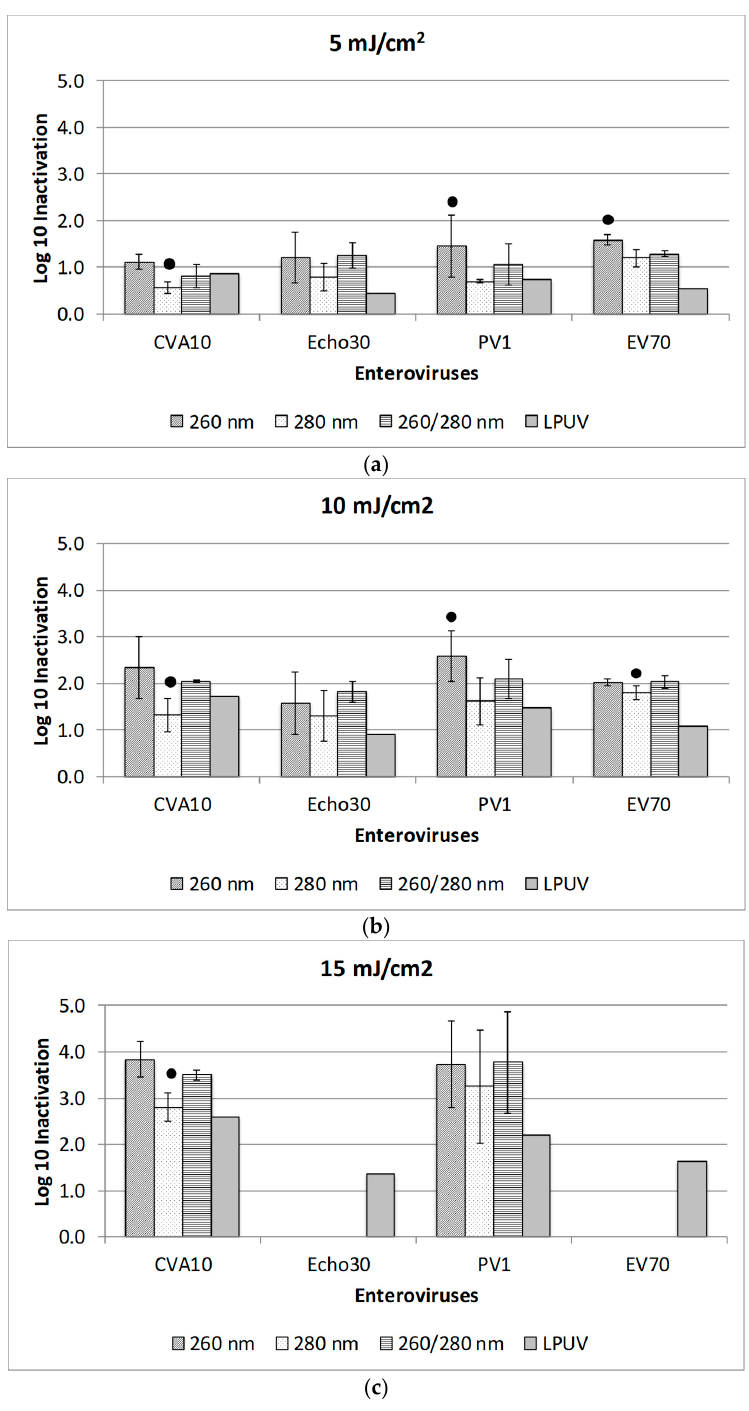
Figure A1. Comparison results of log 10 inactivation rate from the 5 mJ/cm 2 ( a ), 10 mJ/cm 2 ( b ), and 15 mJ/cm 2 ( c ) irradiation of UV-C LEDs for four human enteroviruses. The error bars represent 1 standard deviation. Symbol ( ● ) represents the p value of <0.05 among three wavelengths, as determined by ANOVA. Echo30 and EV70 for a UV dose of 15 mJ/cm 2 were not determined. The log 10 inactivation rates by low-pressure UV (LPUV) at 254 nm were estimated using UV dose–response curves with a UV dose range of 10–30 mJ / cm 2 , adapted from Ryu et al.